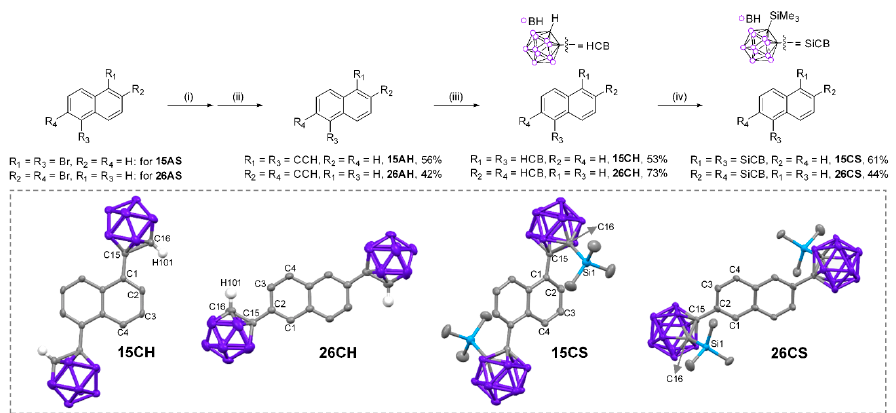
Figure 1. Synthetic procedures for the naphthyl-bis- o -carboranyl compounds. Reagents and condi- tions: (i) CuI, Pd(PPh 3 ) 2 Cl 2 , ethynyltrimethylsilane, THF/NEt 3 , 80 °C, 24 h. (ii) K 2 CO 3 , methanol, 25 °C, 2 h. (iii) B 10 H 14 , N,N-dimethylaniline, toluene, 110 °C, 18 h. (iv) n -BuLi, TMSCl, THF, 25 °C, 2 h. Insets (dash-line box) show the X-ray crystal structures of 15CH , 26CH , 15CS , and 26CS (40% ther- mal ellipsoids), with H atoms on aromatic and aliphatic carbons omitted for clarity.